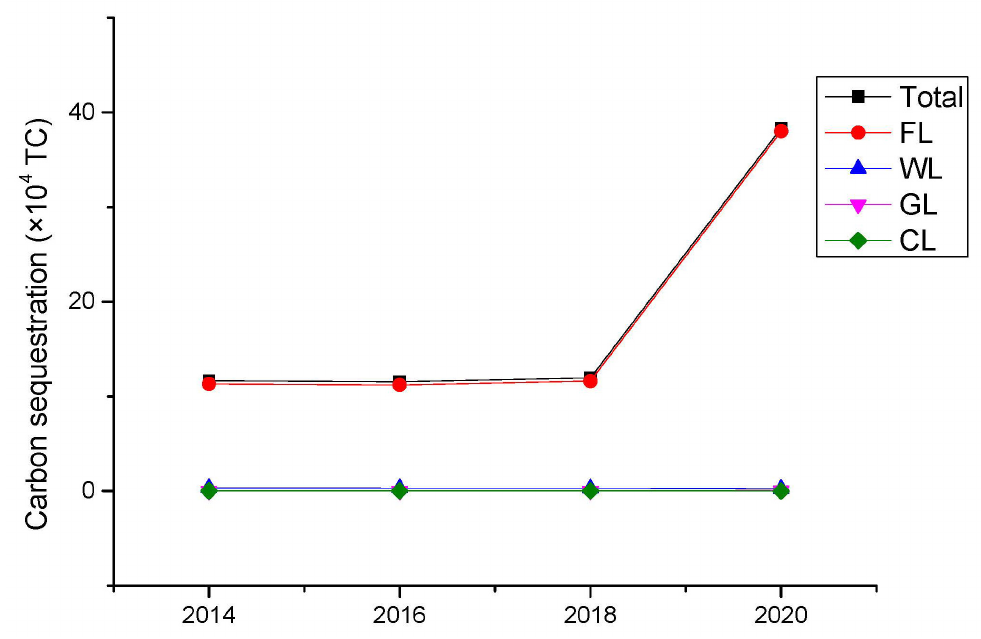
Figure 4. Total carbon sequestration.